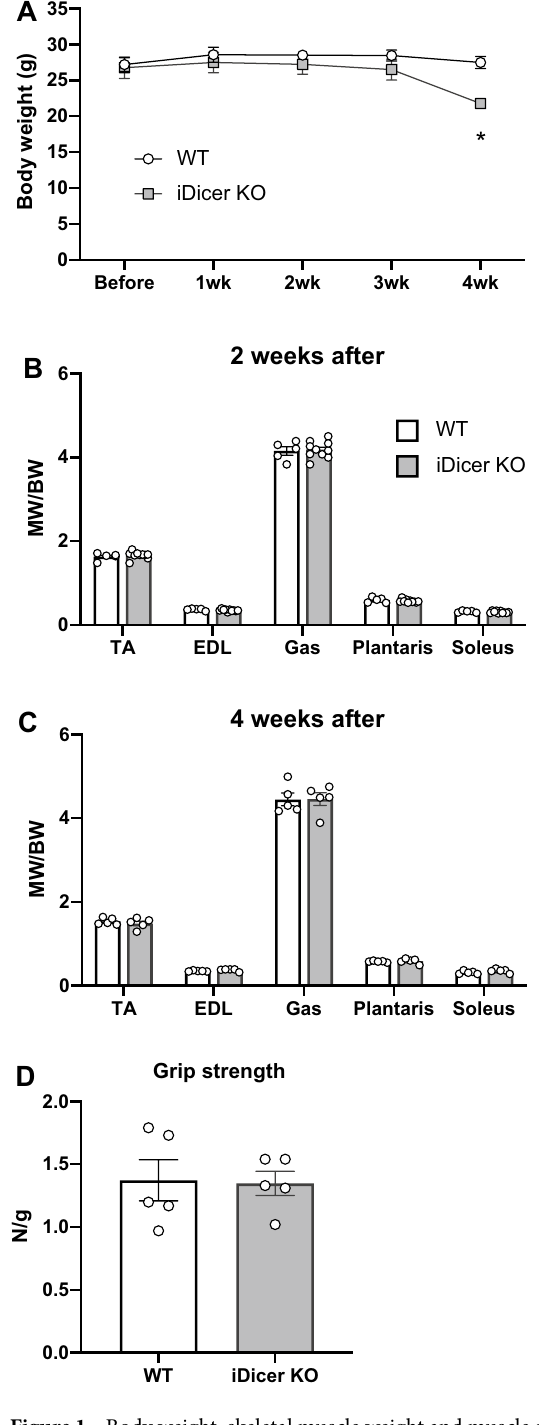
Figure 1. Body weight, skeletal muscle weight and muscle strength in tamoxifen-inducible Dicer knockout mice. ( A ) At 4 weeks post-tamoxifen injection, there were a significant difference in body weight between WT and iDicer KO mice (n = 4–5). ( B , C ) At 2 and 4 weeks after tamoxifen injection, no differences in skeletal muscle weight were observed in iDicer KO mice in comparison with WT mice (n = 4–5). ( D ) Grip strength at 4 weeks post-tamoxifen treatment also did not show significant differences between WT and iDicer KO mice (n = 5). *P <